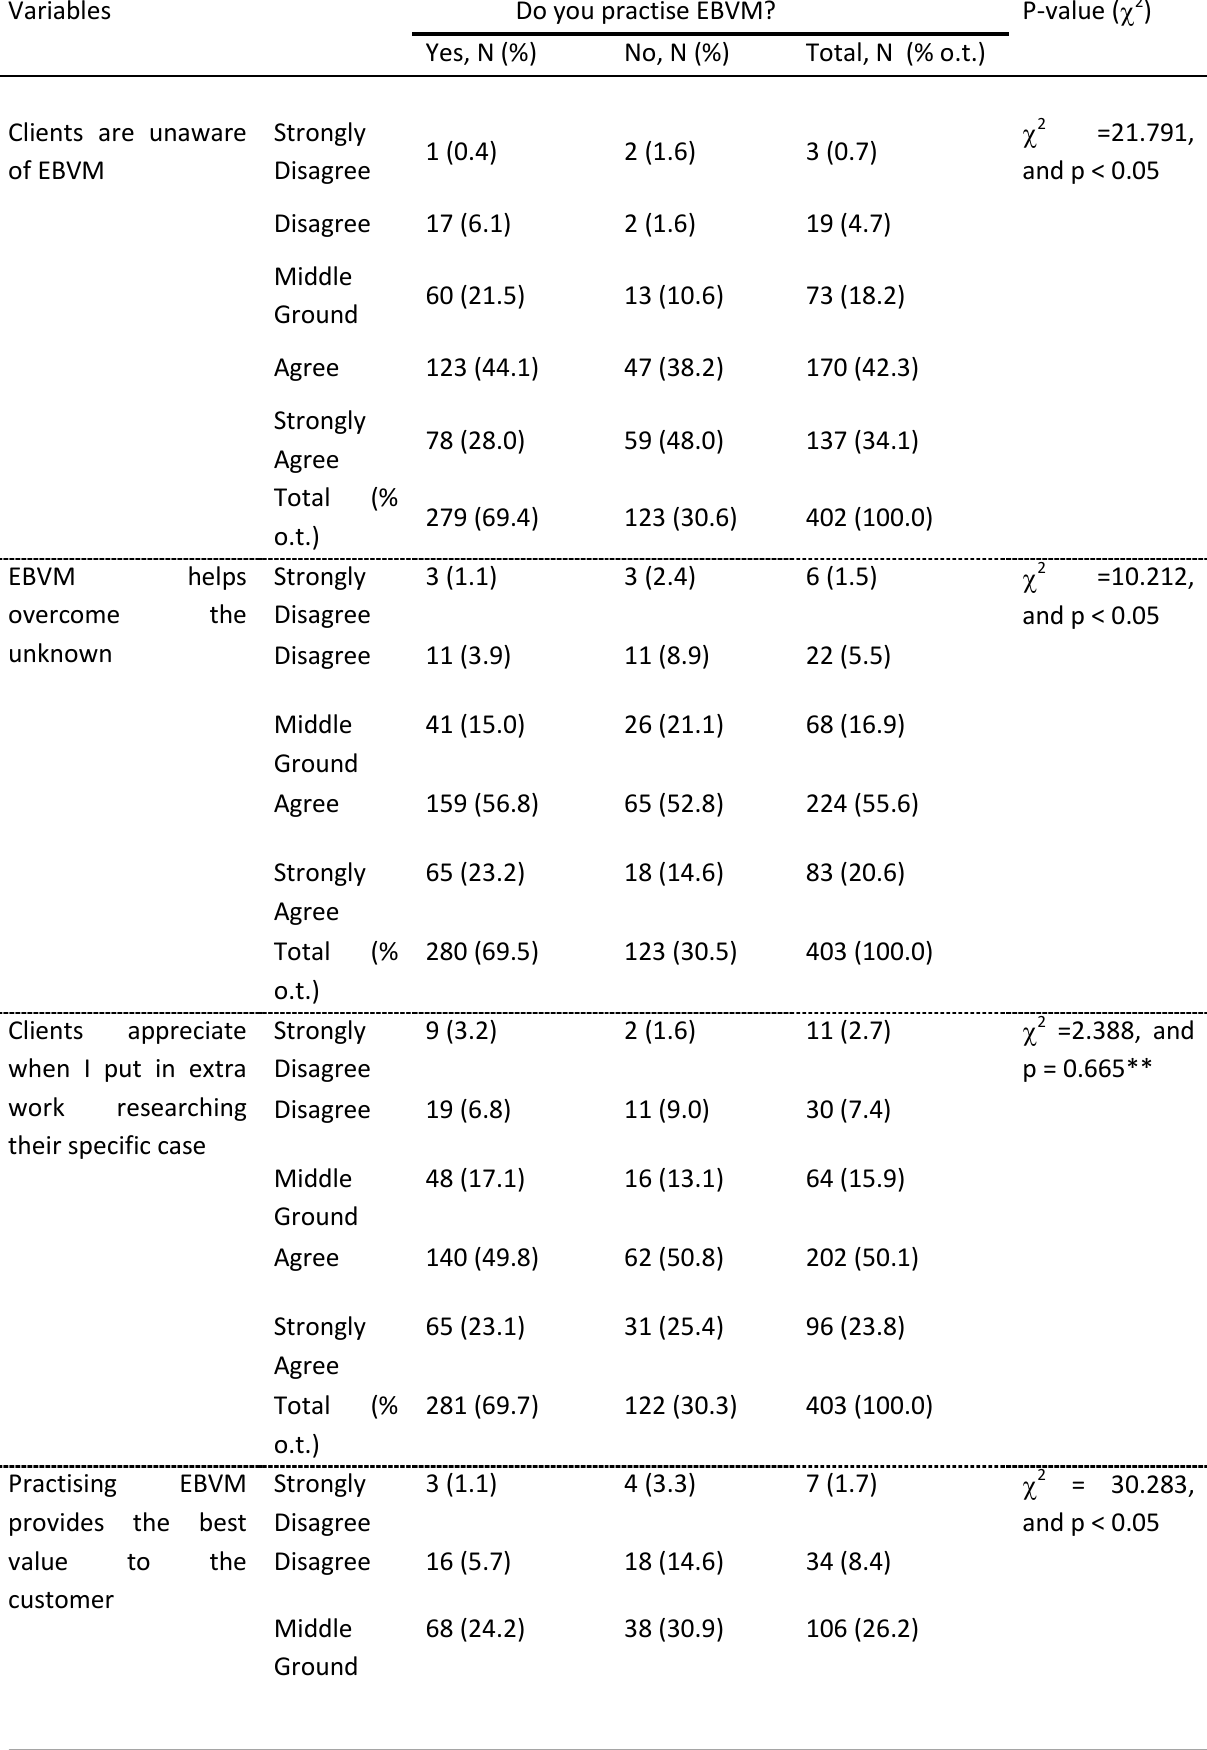
Table 4 : Perceived benefits to the client I Variables Do you practise EBVM? P-value (  2 ) Yes, N (%) No, N (%) Total, N (%